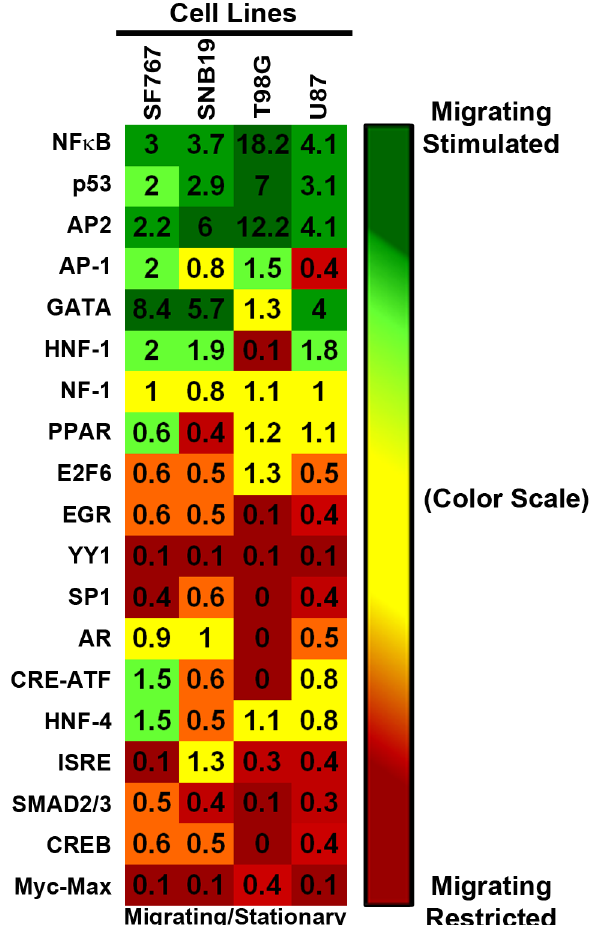
Figure 4. Transcription Factor Profiling of Migrating Glioma Cells vs. Migration-Restricted Glioma Cells. Tumor cells were seeded in either migration-activated ‘‘sparse’’ condition or in migration- restricted ‘‘dense’’ condition on SF767 glioma-derived ECM. Nuclear lysates were collected and hybridized with biotinylated-DNA probes specific to 19 transcription factors as per Marligen’s transcription kit and assayed using the Luminex 200. Two independent biological replicates were performed with each sample in triplicate. Ratios of the averaged mean fluorescent intensities for each transcription factor for sparse over dense were calculated for each biological set and average values of two biological replicates are plotted in the heat map above (For ratios of the average MFI for each biological replicate is presented in Figure S2). The heat map was constructed using a conditionally formatted color range. Green boxes represent the transcription factors activated when cells were in a migration-activated condition (sparse/dense ratios $ 1.5). Red boxes represent transcription factors activated when cells were in a migration-restricted condition (sparse/dense ratios # 0.6). Yellow boxes indicate no change in transcription activity (sparse/dense ratios between 0.65 and 1.5).